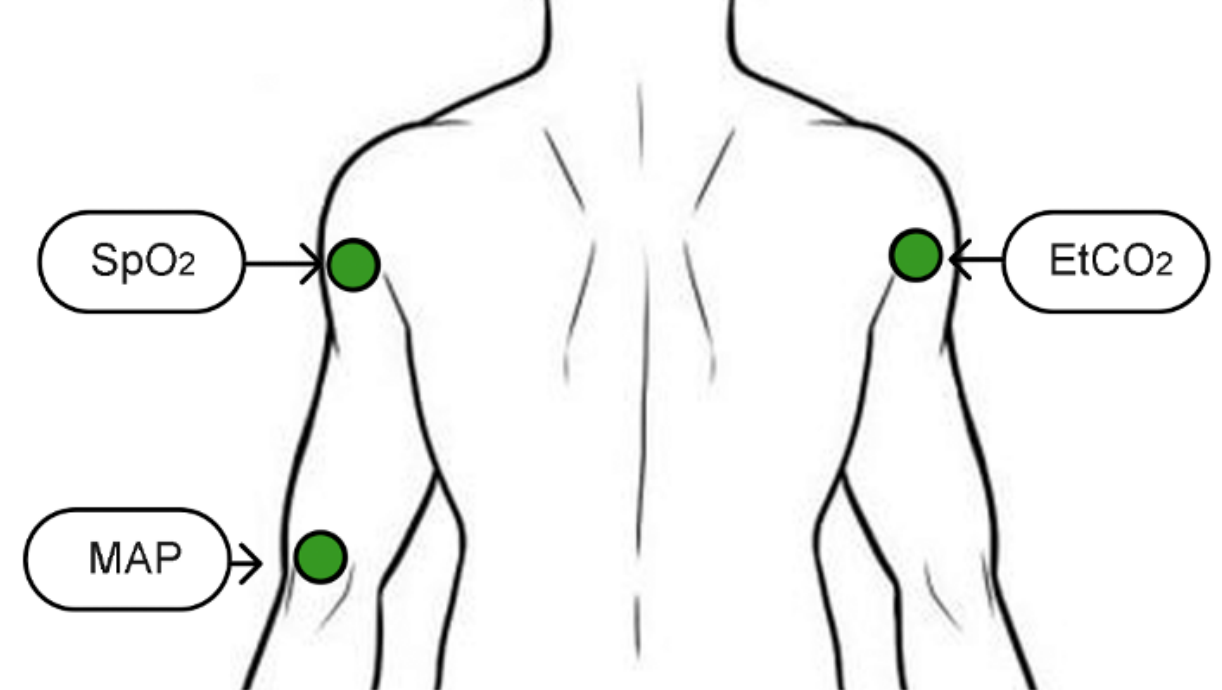
Figure 14. Tactile display, 3 types of alerts used for each variable: increasing, decreasing, and normalizing using 8 consecutive vibrations (500 milliseconds in duration). If the variable value was increasing, the intensity of the vibration increased during the 8 consecutive vibrations, and if the variable value was decreasing, the intensity of the vibration decreased. When the variable value was normalizing, the intensity was kept constant (a model of the concept presented in the paper by Gomes et al [14]). EtCO 2 : end-tidal carbon dioxide partial pressure; MAP: mean arterial blood pressure; SpO 2 : oxygen